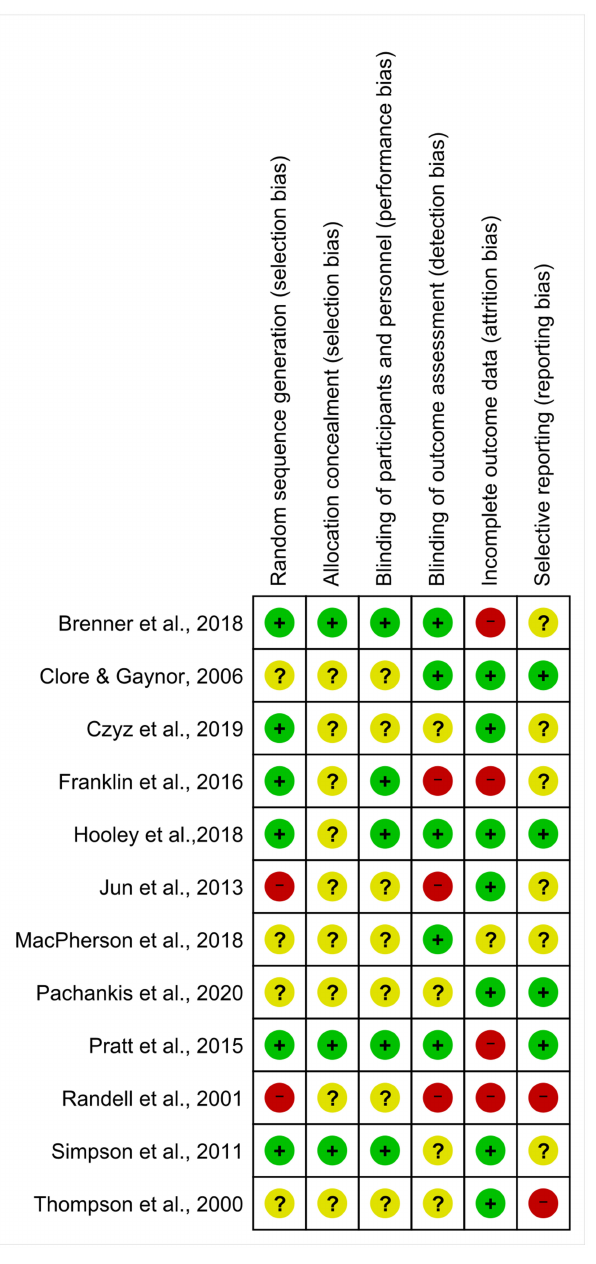
FIGURE 2 | Risk of bias